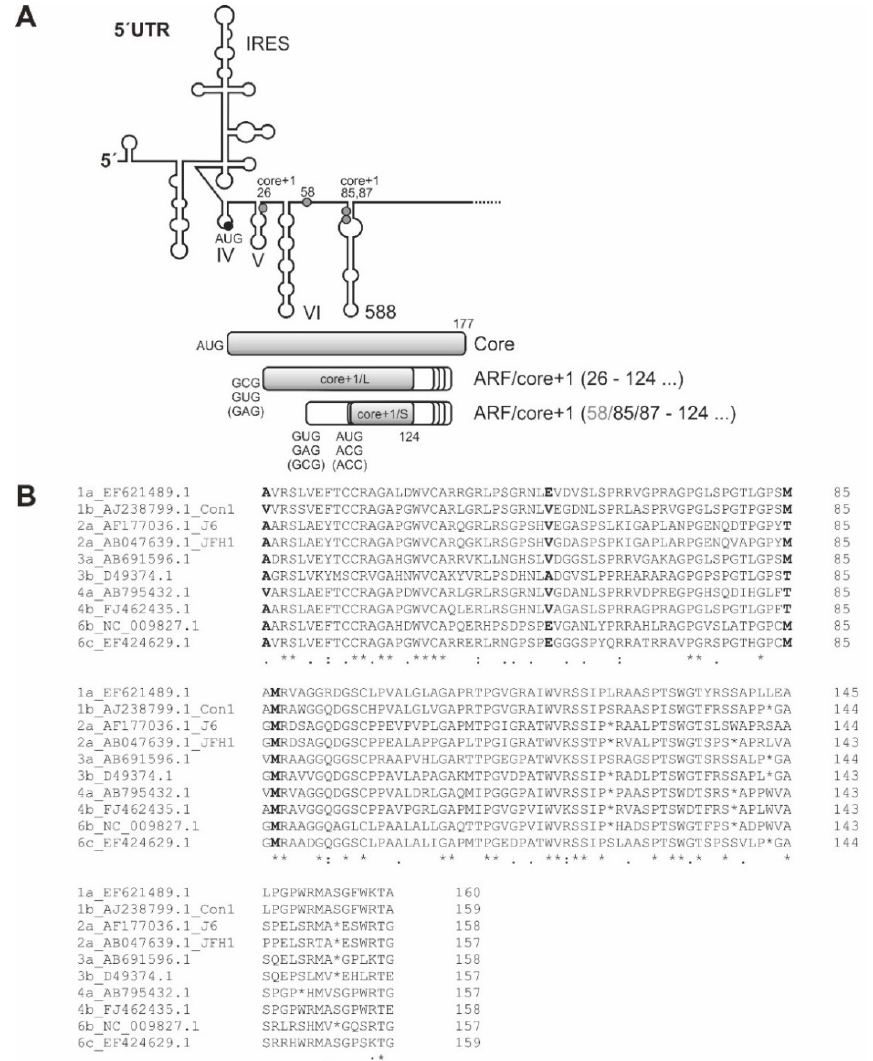
Figure 8. Translation of the HCV alternative reading frame (ARF) or core+1 frame. ( A ) Overview over starts and stops that result in expression of a variety of different ARF of core+1 protein, among HCV isolates. The HCV 5´UTR and the downstream core region is shown essentially as in Figure 1. The start AUG for the canonical core protein is shown in SL IV as black filled circle. The start codons of core+1 protein are shown as grey filled circles at the core+1 frame for positions 26, 58, 85, and 87. The canonical core protein and the various core+1 ARF products are shown as boxes below. The major products produced in genotype 2a are shown in grey, other products produced by initiation at codon 58 or by termination at other more downstream stops in other genotypes are underlayed in white. Start codon usage is depicted; ( B ) Amino acid sequences of representative HCV genotypes and subtypes (selected from [63]); genotypes and NCBI nucleotide database accession numbers are given on the left, as well as abbreviations of some well-known isolates. The AA sequence starts with codon 26 of the core+1 frame, when the nucleotide No. 5 of the canonical core frame, AUGAG, is nucleotide No. 1 of the core+1 frame. The amino acids encoded by the main start codons 26, 58, 85, and 87 are in bold, stop codons are shown by asterisks in the sequence. Conservation is shown under the alignment, with (*) indicating absolute conservation, (:) indicating strongly similar and (.) indicating weakly similar AA properties. The dot indicating similarity between AAs at position 7 in terms of being charged but neglecting charge reversal have been removed, since charge reversal can have serious consequences for proteins [231].